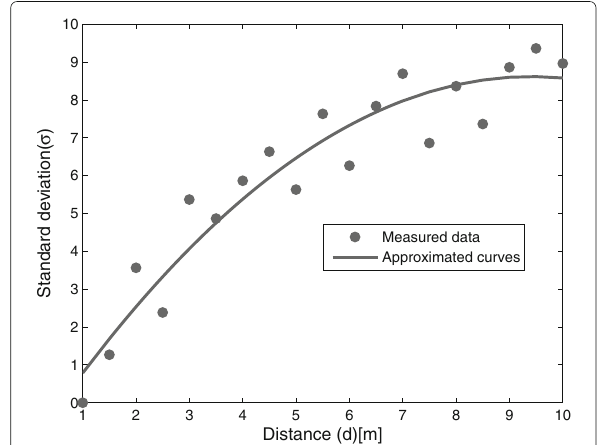
Fig. 5 Relationship of the noise standard deviation and distance for measured